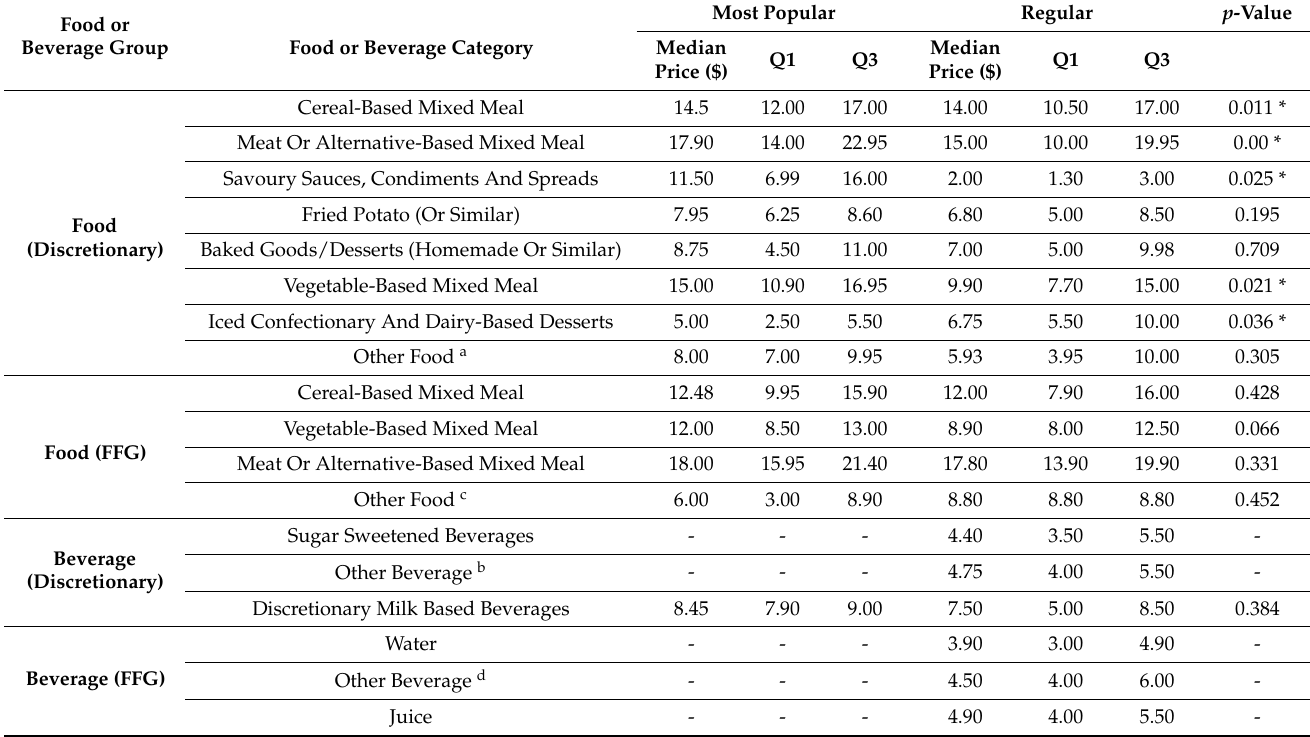
Table 5. Median price of most popular and regular menu items for each food or beverage category. Value bundles were excluded (N = 12,734).